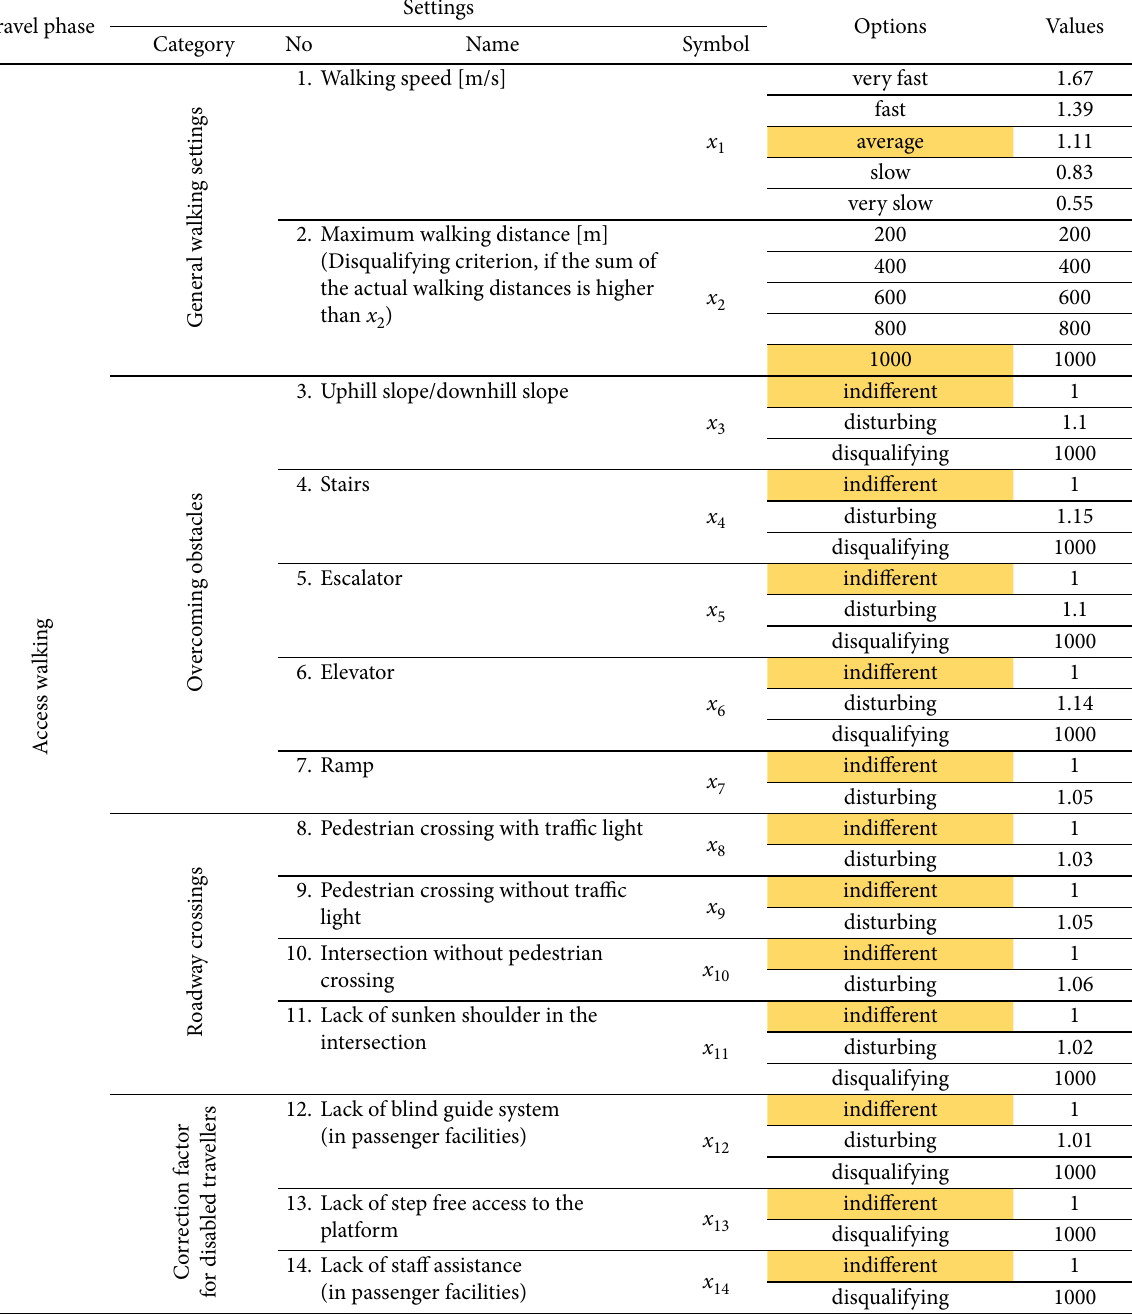
Table 6. Personalised setting options in the access-walking phase (source: research by the authors) Travel phase